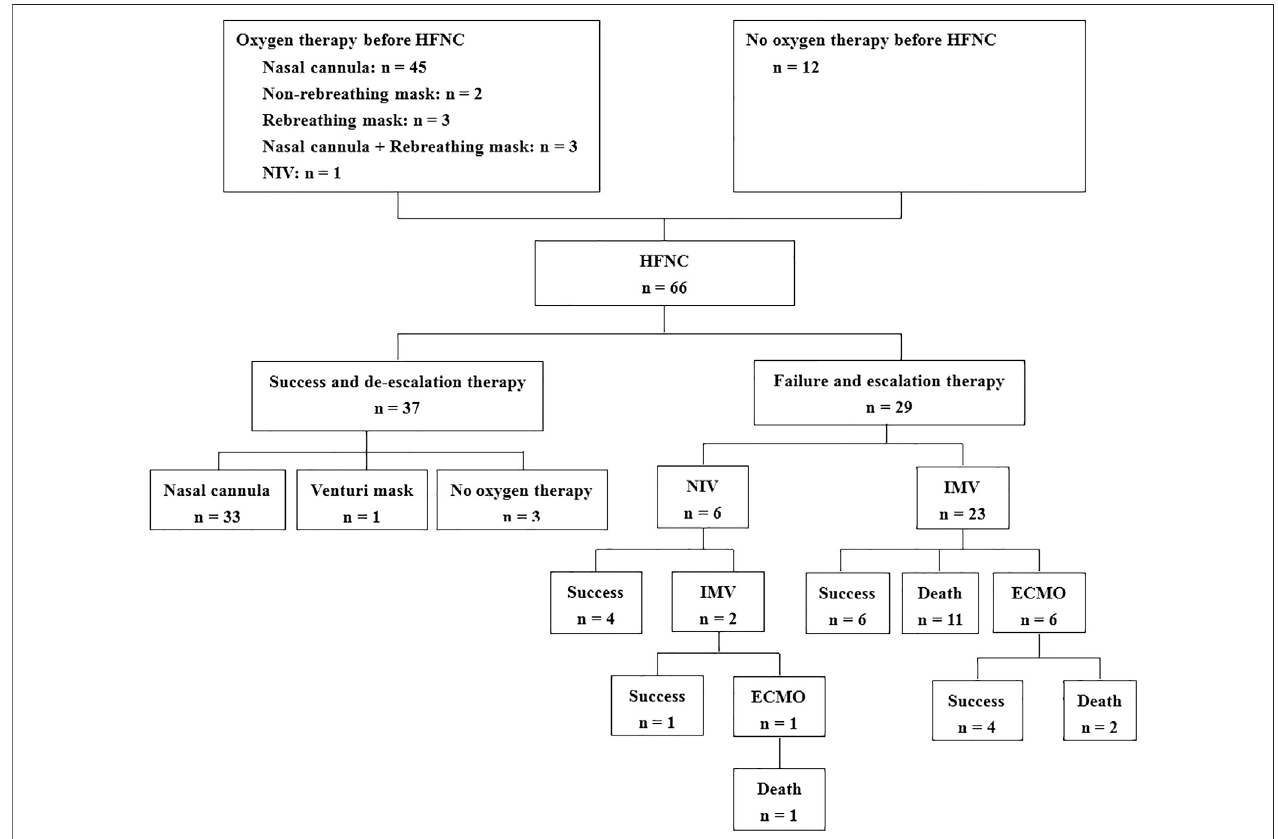
FIGURE 1 | Flowchart of the enrolled patients. HFNC, high- fl ow nasal cannula; NIV, noninvasive ventilation; IMV, invasive mechanical ventilation; ECMO, extracorporeal membranous